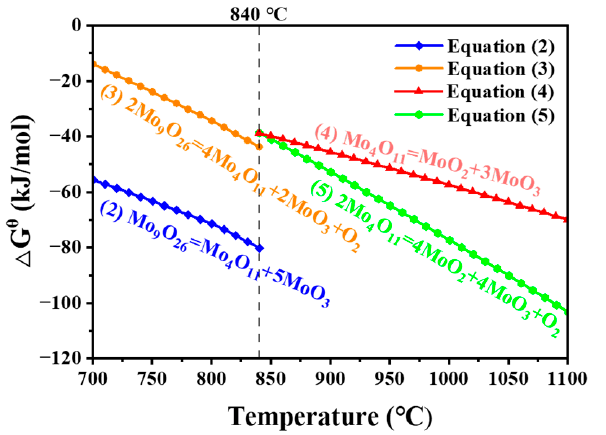
Figure 6. Changes in Gibbs free energy of thermal decomposition of Mo 9 O 26 and Mo 4 O 11 with temperature under standard state.